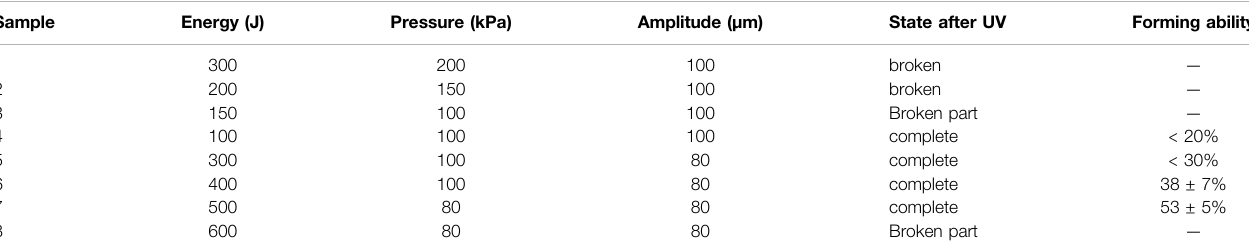
TABLE 1 | Some of the sample results obtained after adjusting the capacity, pressure and amplitude of the UV.